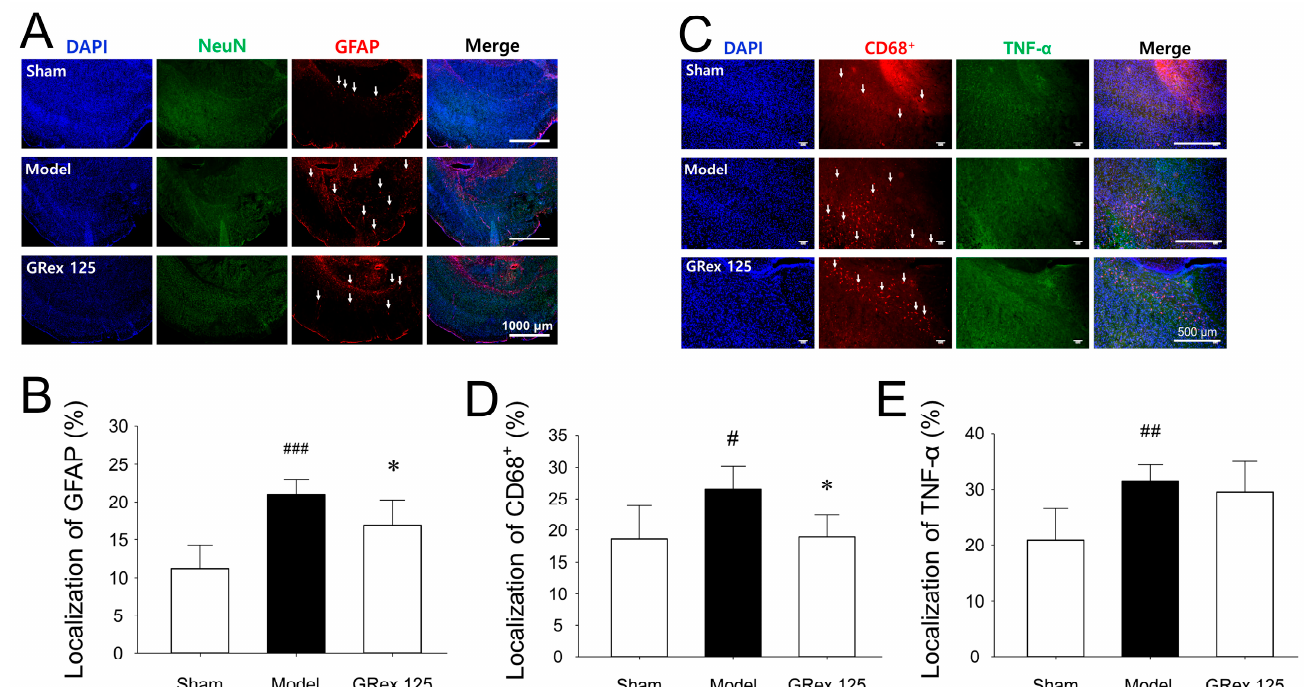
Figure 5. Attenuating neuronal inflammatory response in the cortical area of ischemic ipsilateral hemispheres. Each photomicrograph represents immunofluorescence (IF) ‐ stained cortical regions: ( A , C ) represent IF ‐ stained images of each group; ( B , D , E ) bar graphs represent mean ± SD ( n = 5, per group) of IF color intensities of each antibody. White arrows indicate activated glial cells. All data are expressed as mean ± SD ( n = 5). # p < 0.05, ## p < 0.01, and ### p < 0.001 compared to sham group and * p < 0.05 compared to middle cerebral artery occlusion (MCAO) model group.